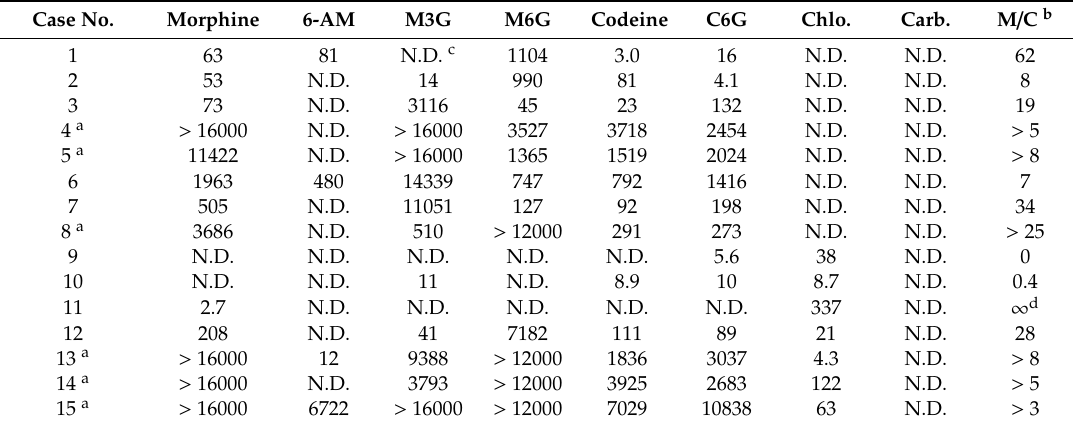
Table 2. Concentrations (ng mL − 1 ) and concentration ratios of opiate, opiate metabolites, and antihistamines in urine samples from 15 people suspected of heroin